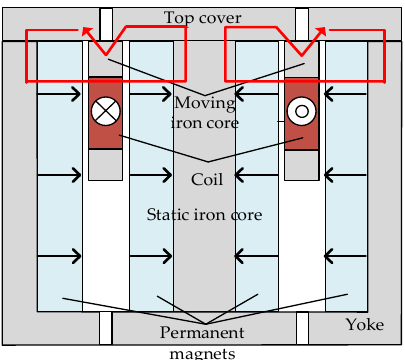
Figure 2. Schematic diagram of the novel contactor structure.